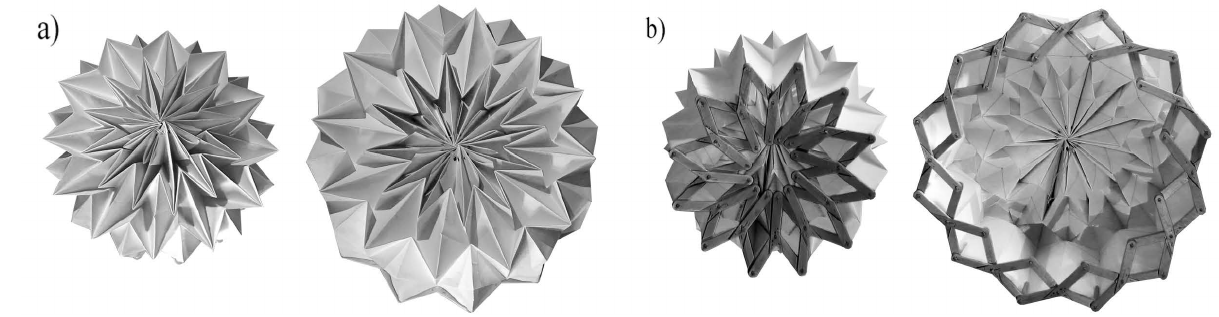
Figure 14: Waterbomb CP deployable shell in retracted and expanded configurations: a) top, b) bottom view